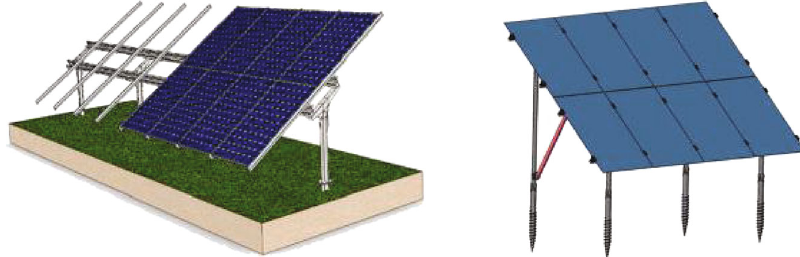
Figure 4: ORMPV installation: photovoltaic system in an open rack installation con fi guration [46].